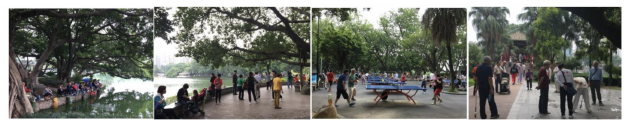
Figure A1. Recreation spaces in Liuhuahu